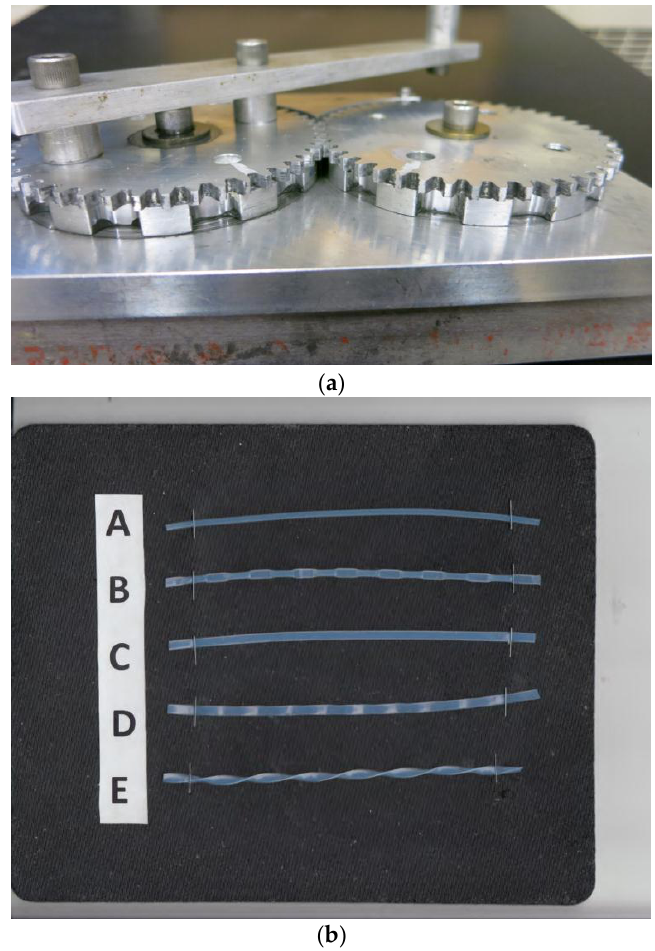
Figure 1. ( a ) Tubing modifier; ( b ) Standard and four differently modified tubings. A: standard; B: Intermittently pressing (IP) 10 mm; C: Flat; D: Flat-wave; E: Flat-twist.